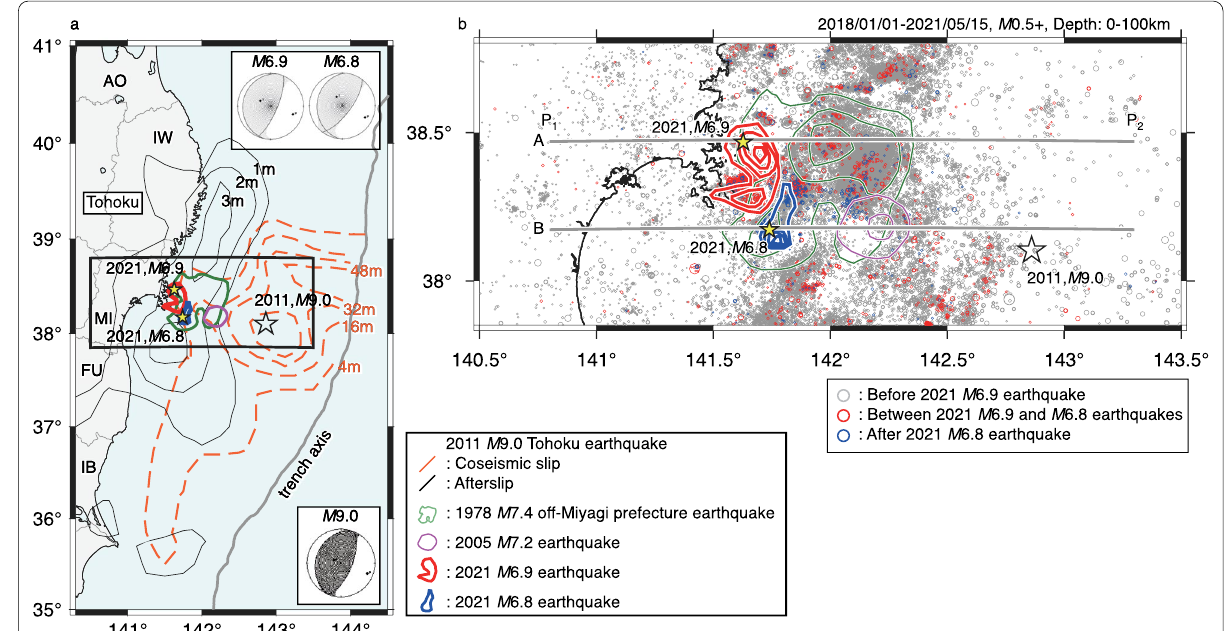
Fig. 1 Earthquakes off the Pacific coast of Tohoku district. a Yellow stars represent the epicenters of the 2021 M 6.9 and M 6.8 earthquakes; open star shows the epicenter of the 2011 M 9.0 Tohoku earthquake. Focal mechanism for these earthquakes, obtained by using the focal mechanism catalog of F-net (Full Range Seismograph Network of Japan) by NIED: National Research Institute for Earth Science and Disaster Resilience (Okada et al. 2004), is displayed as a beach ball symbol. Red and blue regions represent preliminary-determined slip areas of the 2021 M 6.9 and M 6.8 earthquakes, respectively (Tohoku University 2021a). The coseismic slip distribution of the 2011 Tohoku earthquake (Ozawa et al. 2012) is shown by orange contours with an interval of 16 m, except for the interval of 12 m between 4-m contours and 16-m contours. Black contours with an interval of 1 m indicate the afterslip distribution of the same earthquake (Ozawa et al. 2012). Green and purple regions show coseismic slip areas of the 1978 M 7.4 off-Miyagi prefecture earthquake (Yamanaka and Kikuchi 2004) and the 2005 M 7.2 earthquake that occurred at off-Miyagi prefecture (Yaginuma et al. 2006), respectively. Black rectangle shows the study region in b . AO (Aomori), IW (Iwate), MI (Miyagi), FU (Fukushima), IB (Ibaraki) are abbreviations of prefecture names. b Seismicity (depth 0–100 km, M 0.5) in and after 2018. Cross-sectional views along the line segments from P 1 ≥ to P 2 , indicated by “A” and “B”, are shown in Fig. 3. Red and blue contours with an interval of 0.4 m indicate the coseismic slip distributions of the M 6.9 and M 6.8 earthquakes, respectively (Tohoku University, 2021a). We traced each slip contour from the original (Tohoku University 2021a), created numerical data that list the longitude and latitude consisting of the slip contours (Additional files 2 and 3 for the M 6.9 and M 6.8 earthquakes, respectively), and drew the contours using the numerical